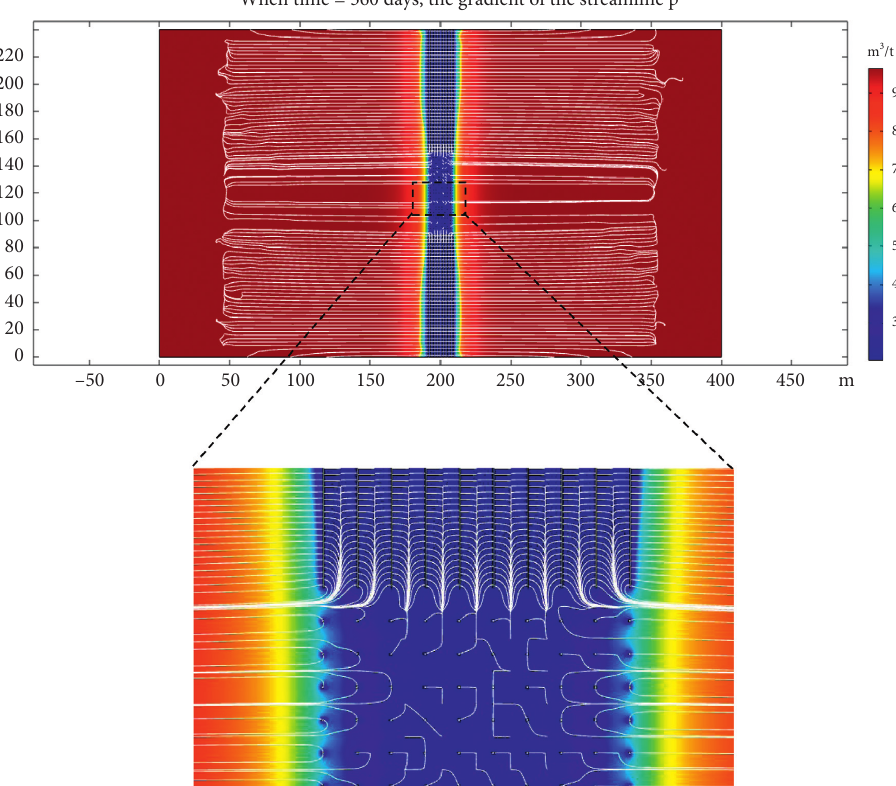
Figure 9: Streamline diagram of the combined layout of penetrating boreholes and the long boreholes along the seam.